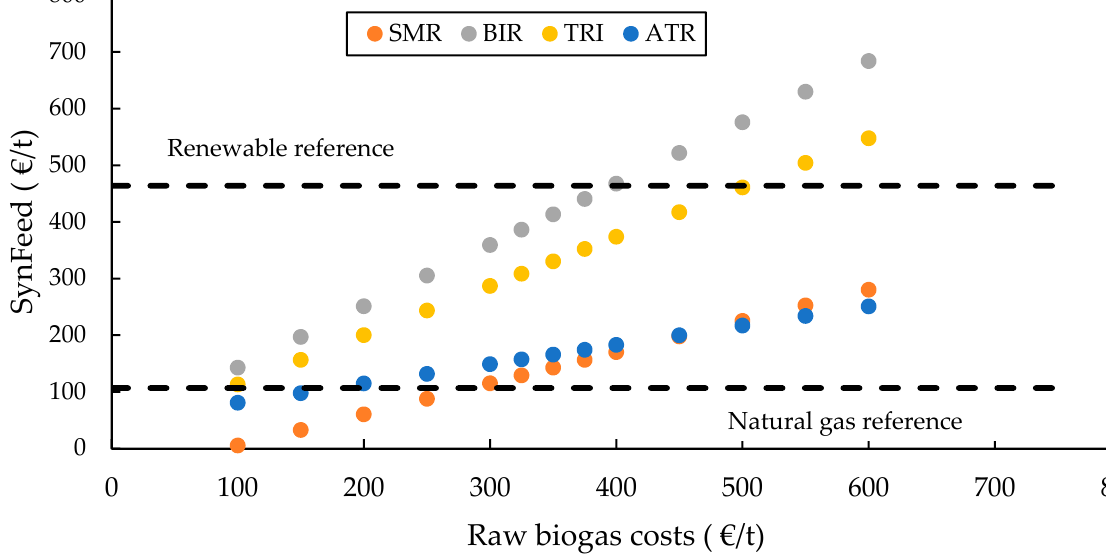
Figure 12. Net production costs of adjusted SynFeed for different raw biogas costs for separation conditions.